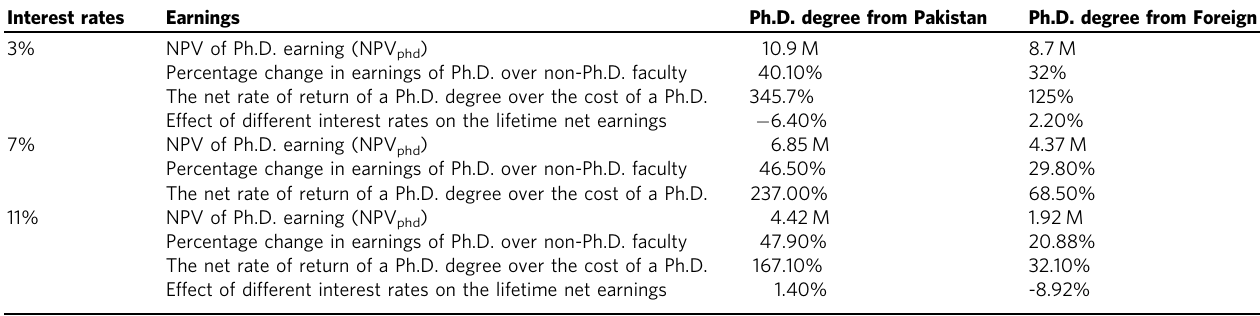
Table 12 NPV of earnings of Ph.D. over non-PhD faculty at different interest rates. Interest